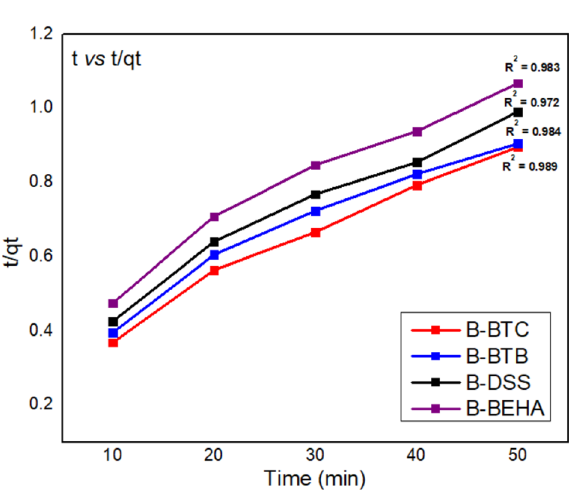
Figure 6. Pseudo second order kinetics for the adsorption of DBT onto